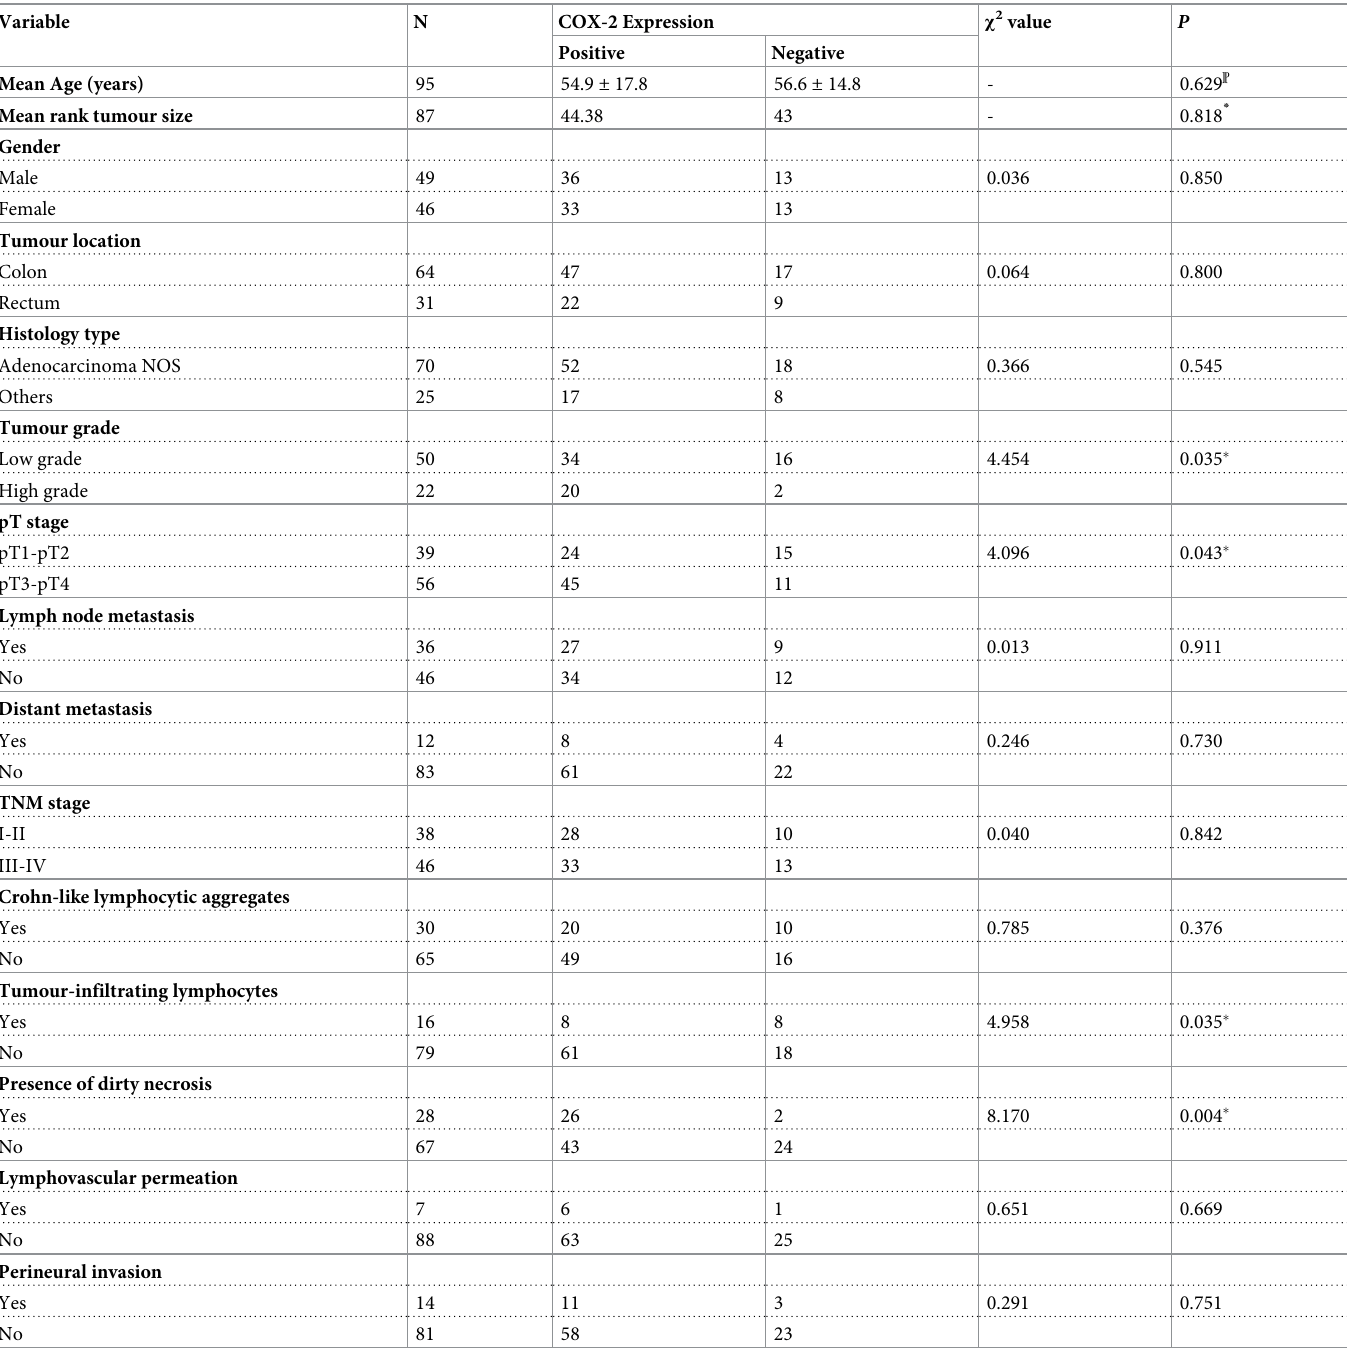
Table 3. Relationship between COX-2 expression and some clinicopathological features of the